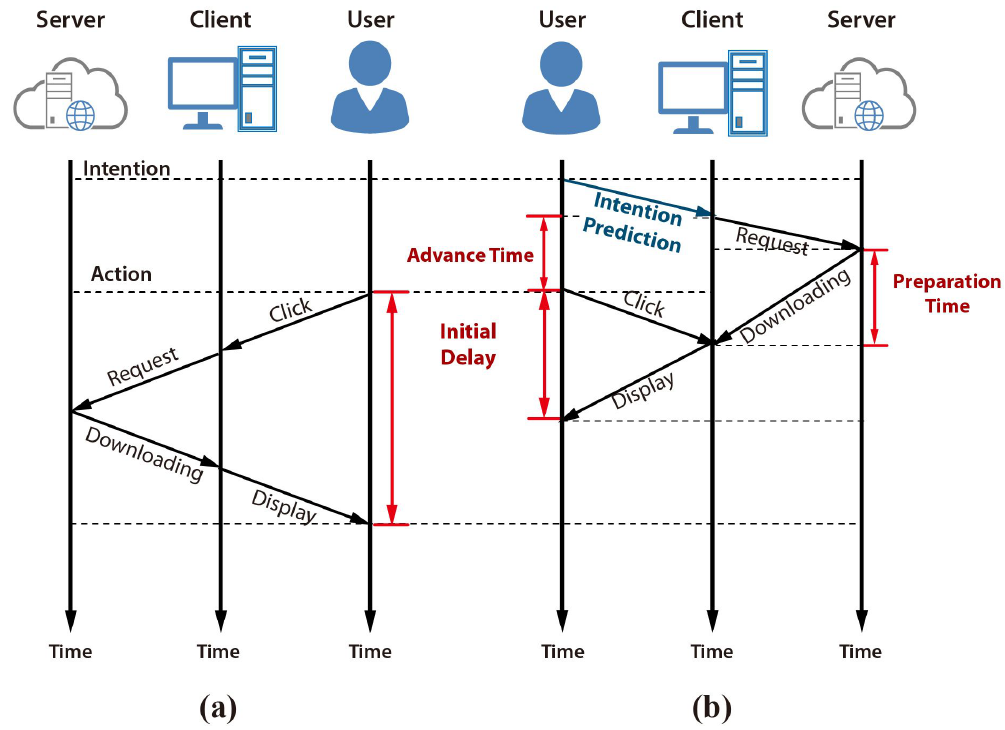
Figure 1. Process flow of web access. ( a ) Typical web video access; ( b ) web video